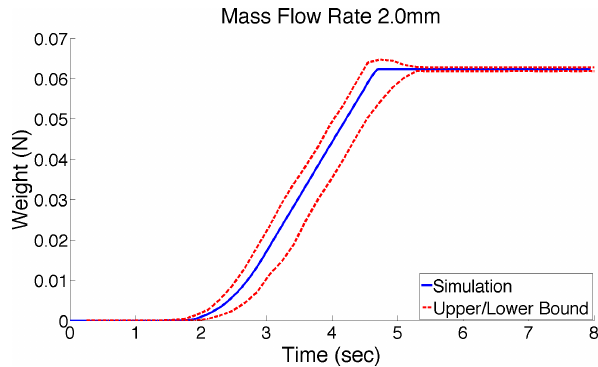
Figure 13 : Weight vs time for a gap size of 2 mm.